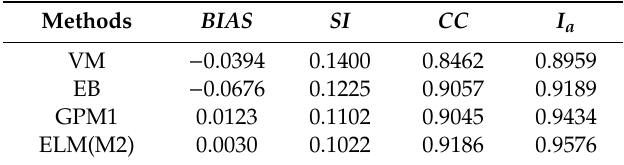
Table 4. The evaluation indices of the performance of di ff erent models (8 < S < 32).